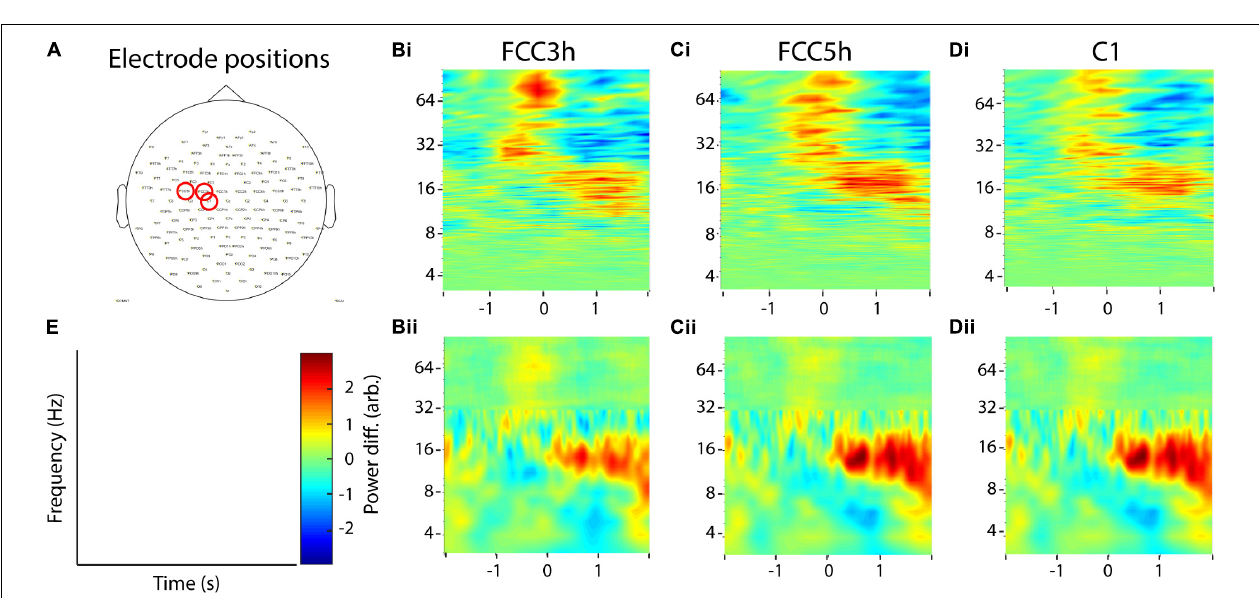
FIGURE 11 | Example application on noninvasive EEG data. (A) Selected electrodes in the motor area of one healthy adult. (Bi–Di) Recurrence analysis of three example electrodes. (Bii–Dii) Corresponding combined multitaper-wavelet analysis of the same electrodes. All power values were normalized with respect to the total power of the analyzed time window. (E) Colorbar and axis labels for Subfigures (B–D) .